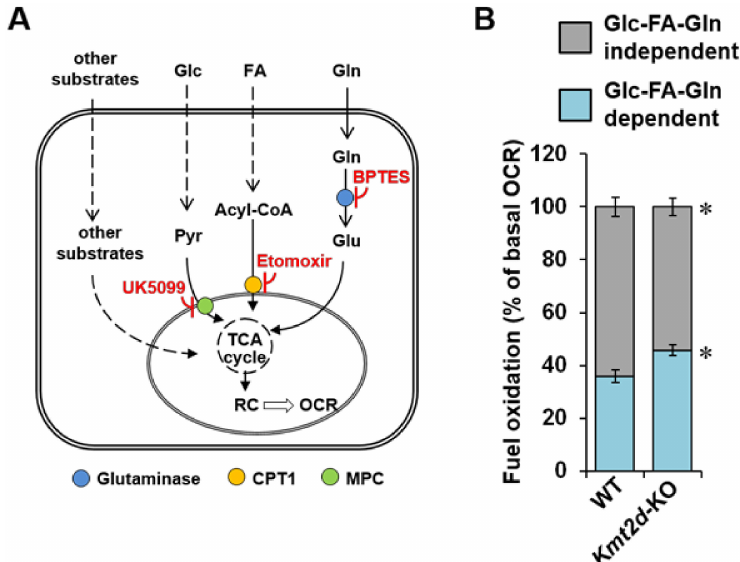
Figure 6. Measurement of the reliance on respiratory substrates in Kmt2d -KO and WT-MEF. Resting OCRs were assessed in cells by a Seahorse Analyser in the absence and in the presence of a cocktail of inhibitors (UK5099, etomoxir, and BPTS). ( A ) The targeted pathways of the inhibitors are shown; CPT1, carnitine palmitoyl transferase 1; MPC, mitochondrial pyruvate carrier; Glc, glucose; FA, long-chain fatty acids; Gln, glutamine; Glu, glutamate; Pyr, pyruvate. ( B ) Histogram showing the Glc / FA / Gln-dependent and Glc / FA / Gln-independent OCRs expressed as percentage of the rotenone + antymicin A-sensitive OCR; means ± SEM of n = 4 independent biological replicates in triplicate; *, P <